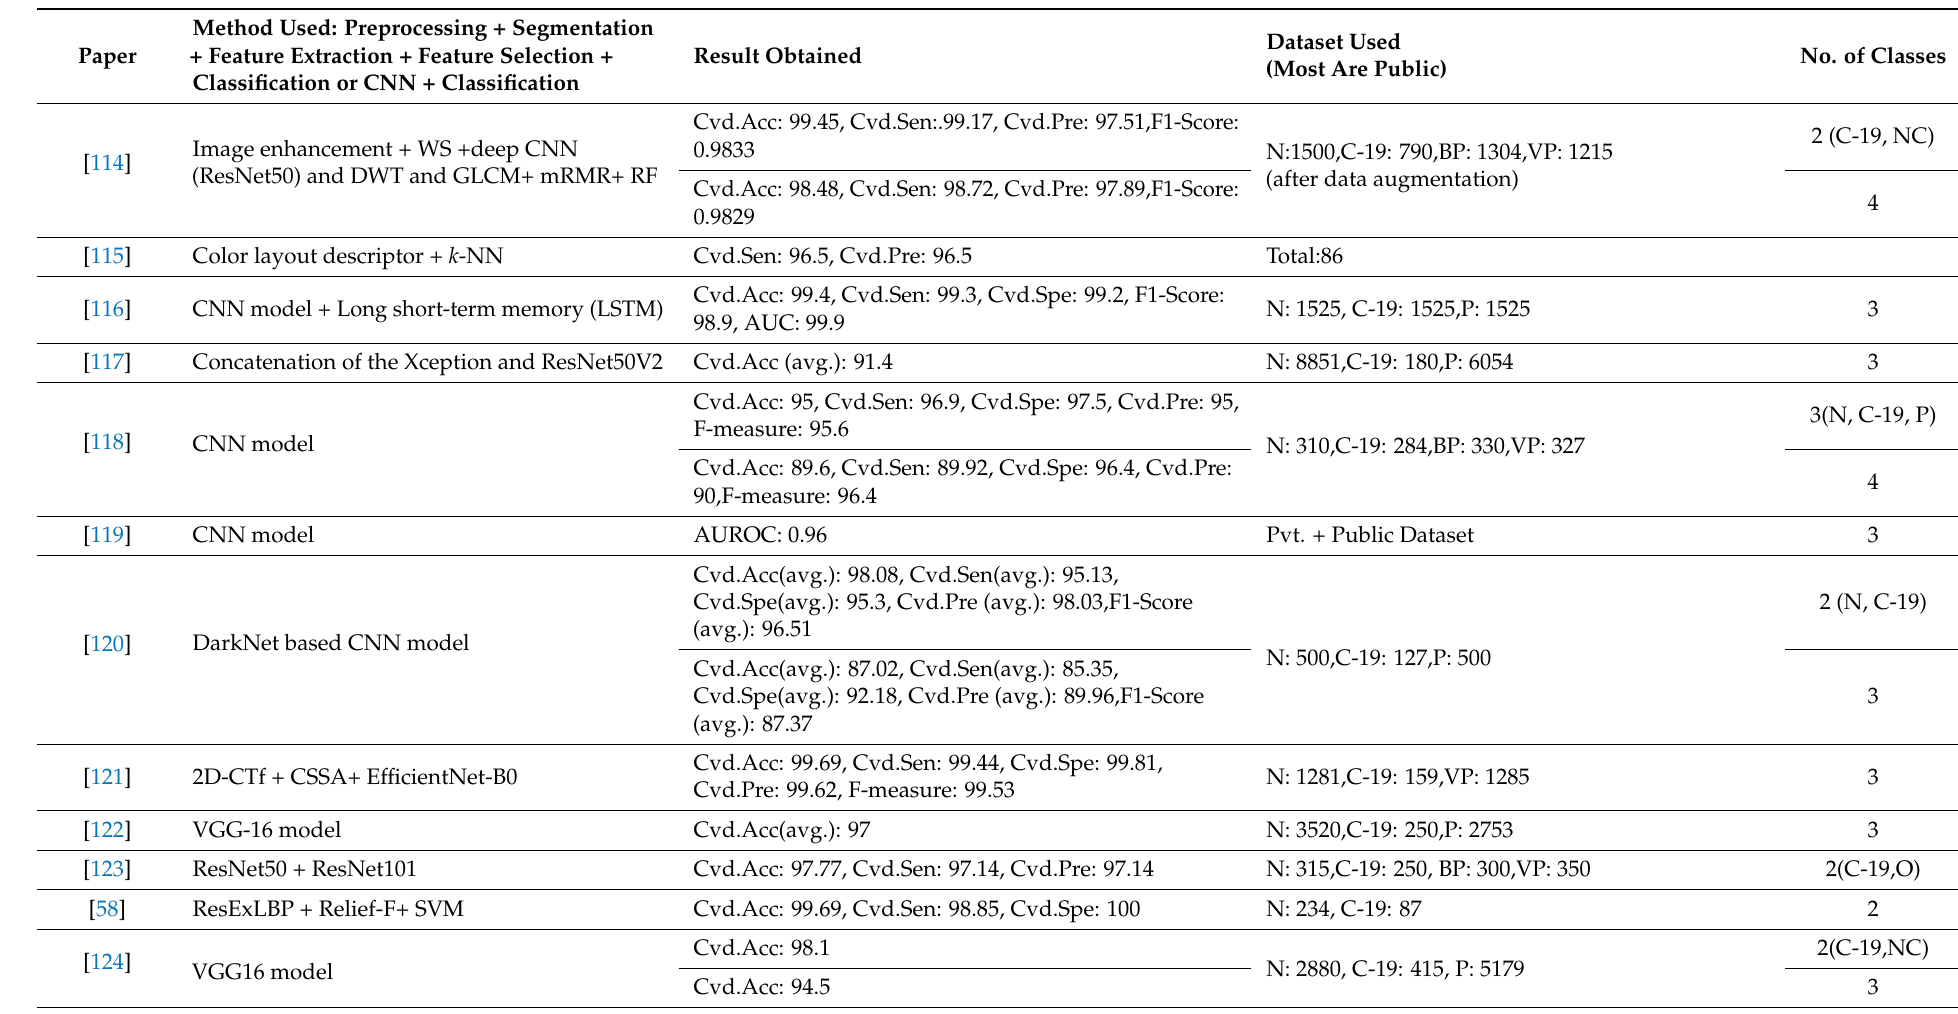
Table 2. State-of-the-art AI techniques to detect COVID-19 using chest X-ray